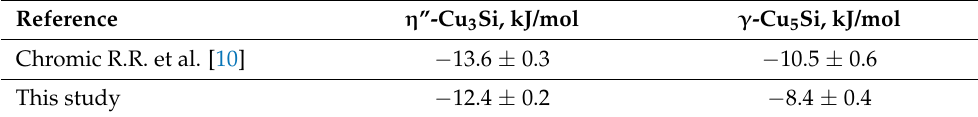
Table 8. Formation enthalpies of copper silicides in the thin films.